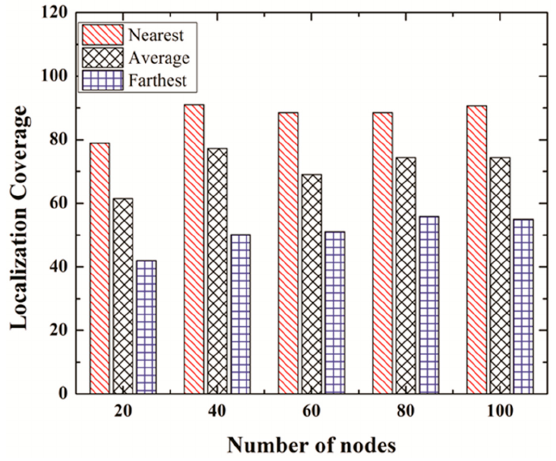
Figure 13. Localization coverage for different CH positions.